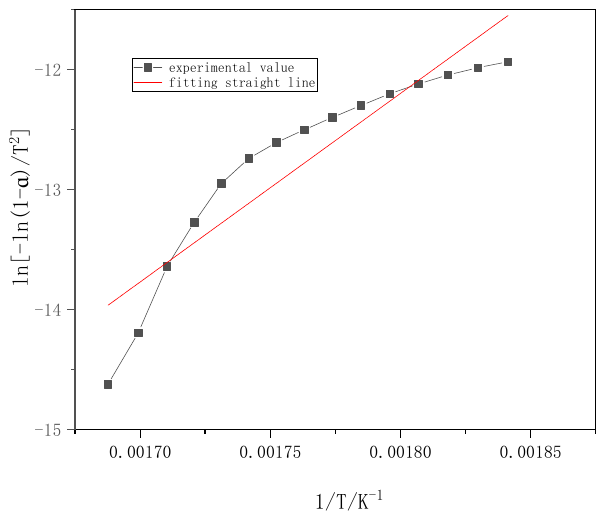
Figure 5. Fitting straight line for burning stage of willow (270 – 320 °C).